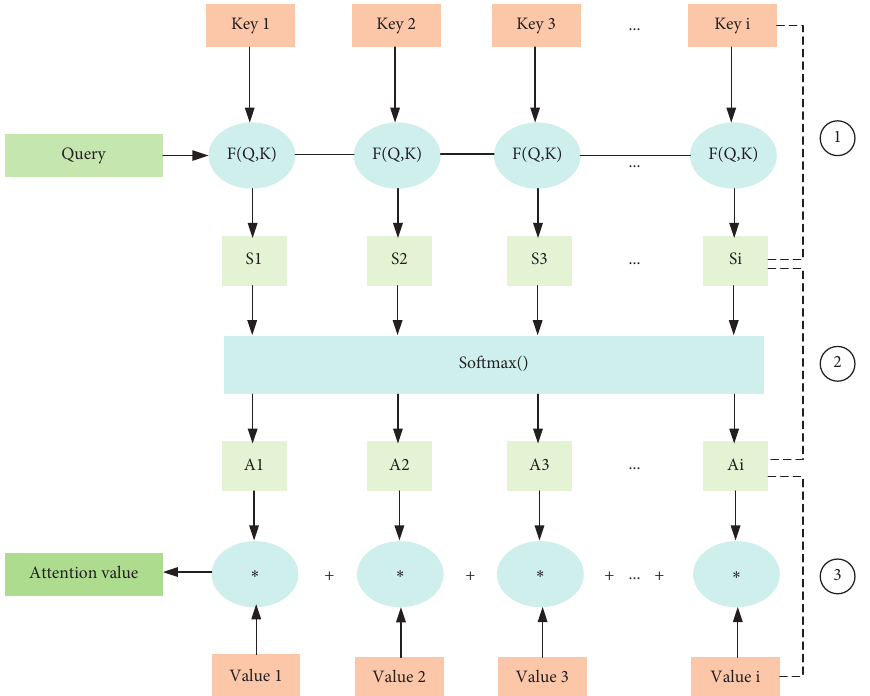
Figure 2: Example to illustrate the process of building an attention model.